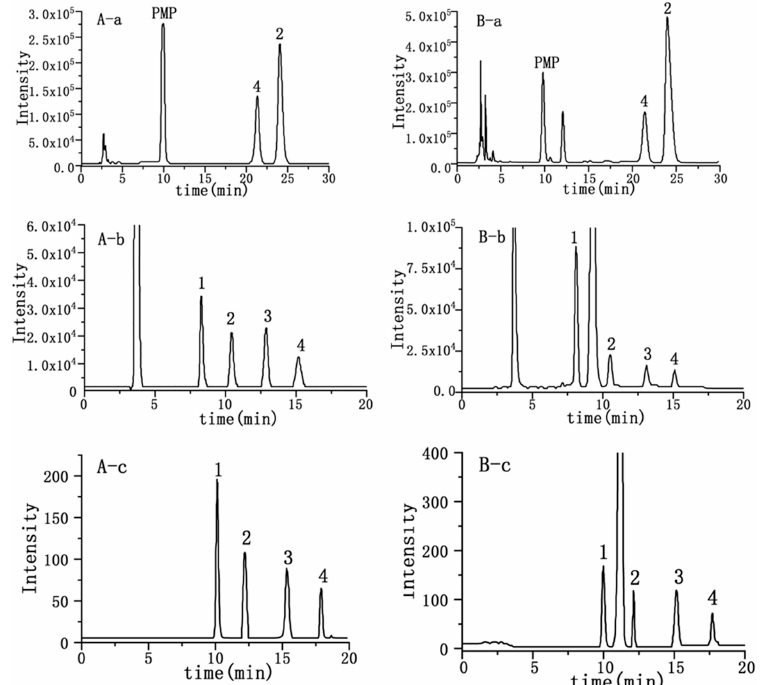
Figure 2. Chromatograms of standard solution ( A ) and sample solutions ( B ) of sugars from YQFM for PMP-HPLC ( a ), HPLC-RID ( b ) and HPLC-ELSD ( c ). Numbers 1–4 correspond to fructose, glucose, sucrose and maltose, respectively. Table 1. HPLC-based calibration function parameters for compounds, including regression equations, correlation coefficients ( r ) and linearity range.